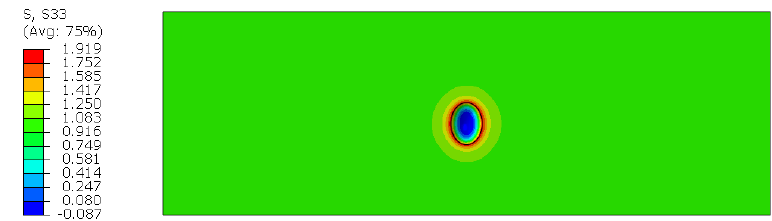
Figure 13. Numerically computed axial stress S33 for ellipsoidal gas pore of Figure 7.